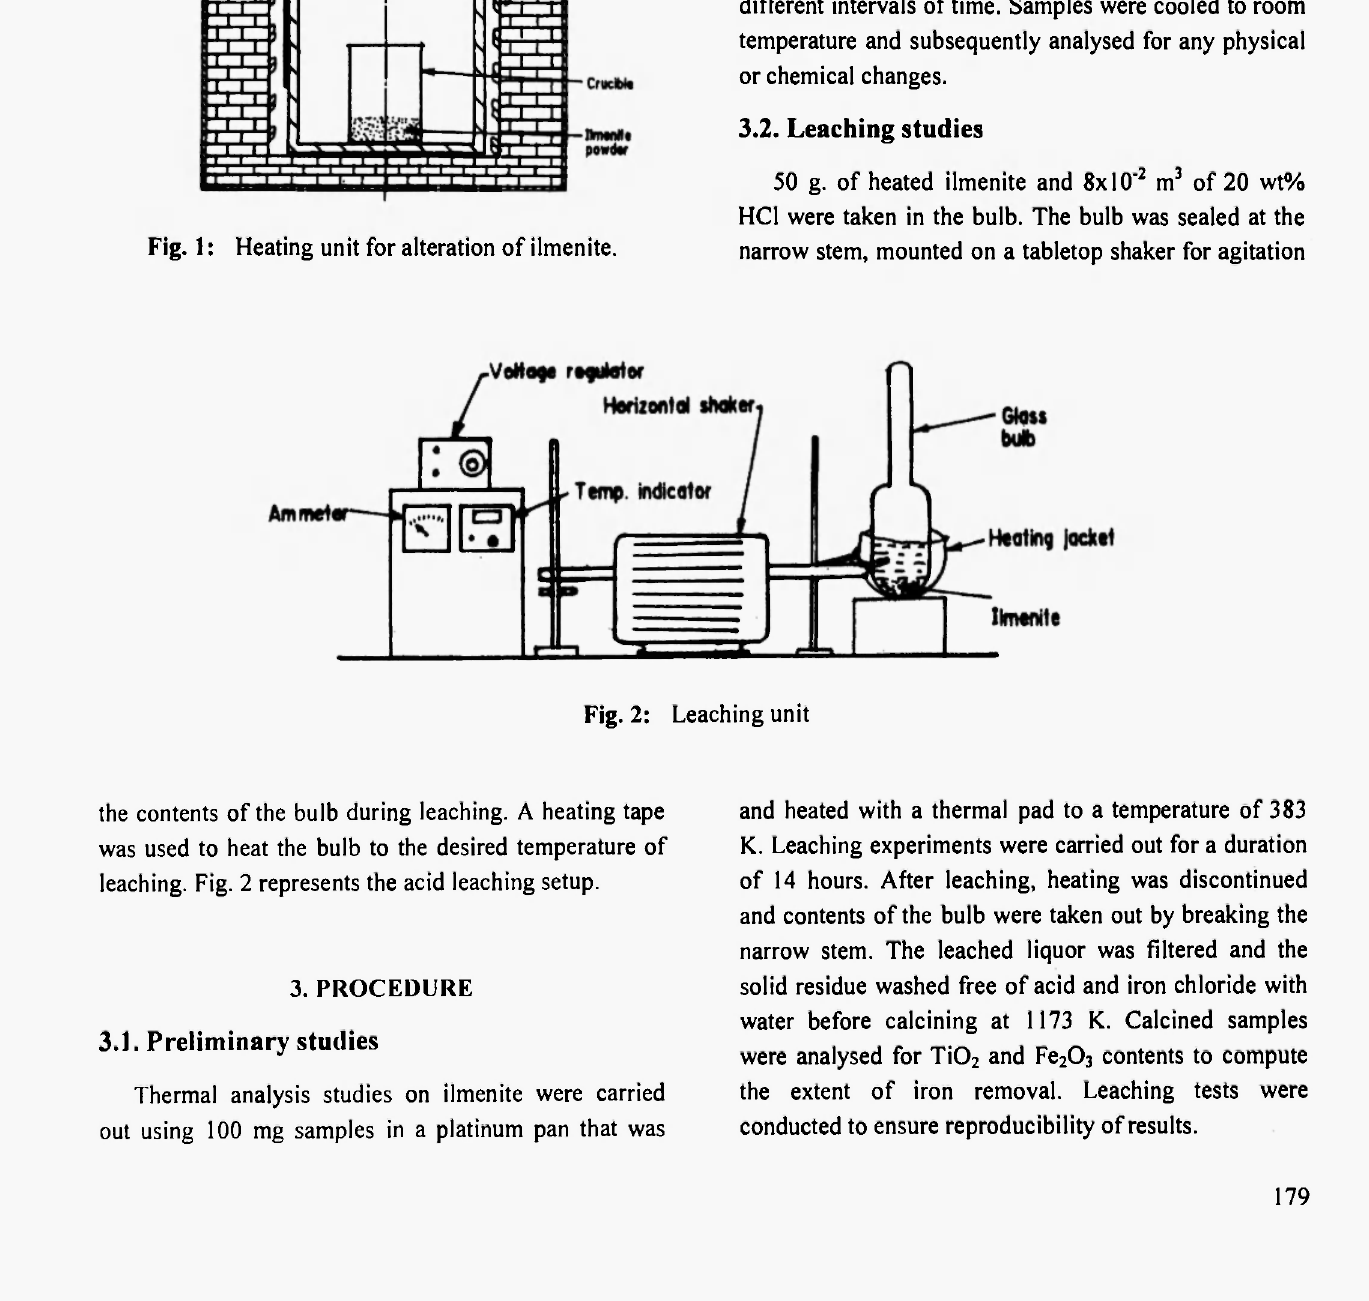
Fig. 1: Heating unit for alteration of